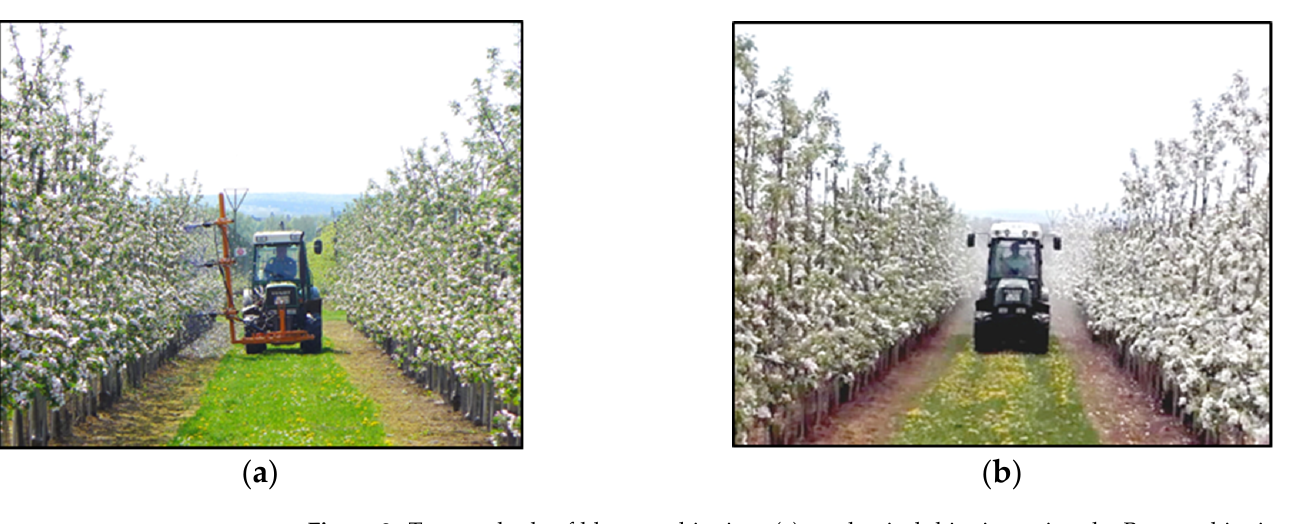
Figure 2. Two methods of blossom thinning: ( a ) mechanical thinning using the Bonner thinning device, and ( b ) chemical thinning.